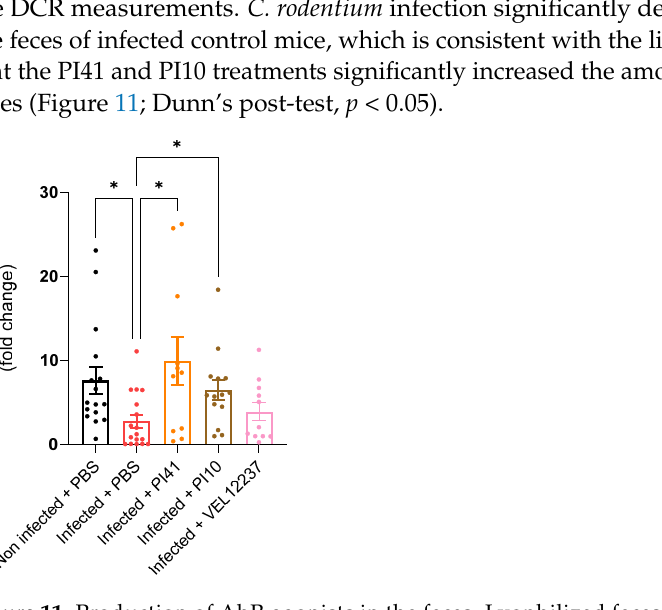
Figure 10. Change in intracolonic pressure following colorectal distensions. Infected + PBS, n = 17; Infected + PI10, n = 18; Infected + PI41, n = 18; Non-infected + PBS, n = 17. To analyze the data, we carried out a linear mixed model with repeated measures (repeated recordings, following increasing pressure) with Geisser Greenhouse correction; then, Dunnett’s post hoc multiple comparisons with a comparison of the means obtained for each treatment group was applied for each pressure. ‘Pressure’ factor, p < 0.0001; ‘treatment’ factor, p = 0.0002. At 40 mmHg and 80 mmHg, strains PI41 significantly limited colonic hypersensitivity compared with infected + PBS. Infected + PBS vs. Non infected + PBS; * = p ≤ 0.05, ** = p ≤ 0.01; Infected + PBS vs. Infected + PI41; *: p ≤ 0.05 (mean ± SEM).